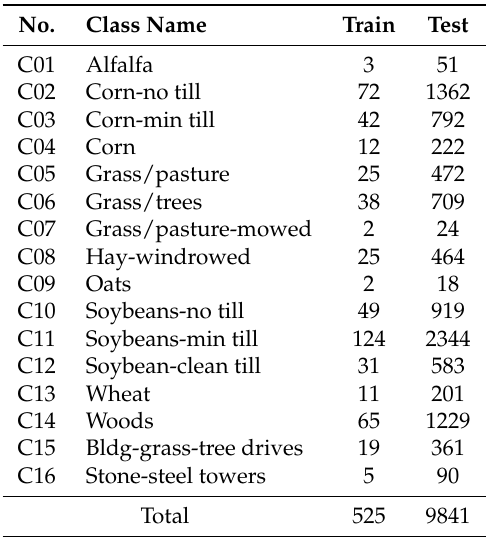
Table 1. The ground reference classes in the AVIRIS Indian Pines dataset and the number of training and test pixels used in experiments.